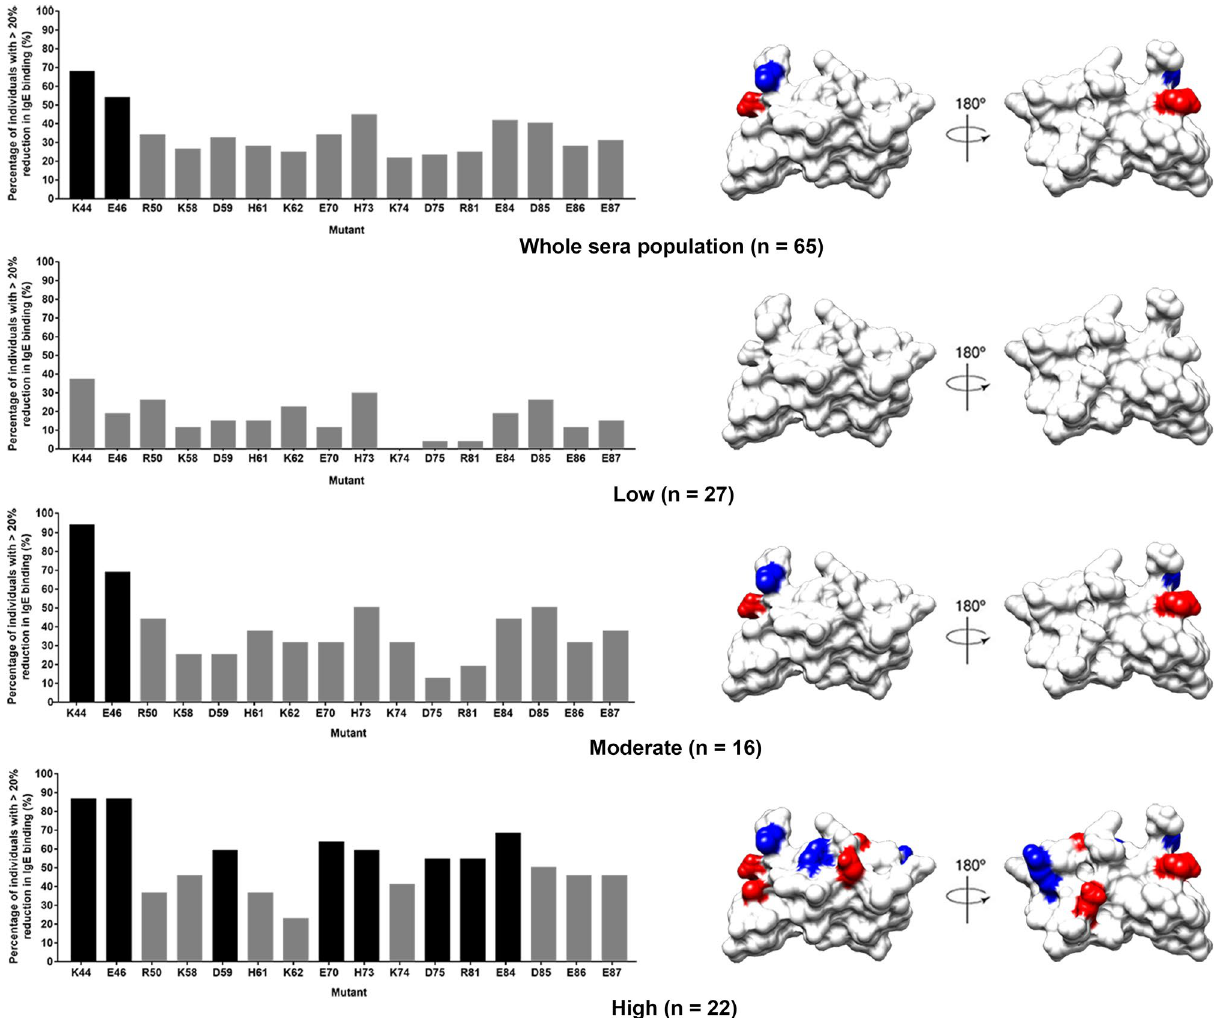
Figure 3. The site-directed mutagenesis for the determination of the IgE-binding residues of rDer p 23. Mutations that cause more than 20% reduction of the IgE binding in the individual sera are considered significant. Percentage of individuals showing > 20% reduction of IgE binding compared to wild type rDer p 23 was plotted for each mutant. Mutations that cause a significant reduction in the IgE binding in over 50% of individuals (the major IgE-binding residue) are highlighted in black and their location on the rDer p 23 structure is mapped (right panel). Graph (left panel) and surface diagram (right panel) showing the major IgE-binding residues for the whole population regardless of their rDerp23-sIgE levels, and the classified rDerp23-sIgE sera (low, moderate, and high IgE-binding intensity group). Blue: positively charged residues; Red: negatively charged residues. The electrostatic surface charge diagram was generated using program Chimera 37